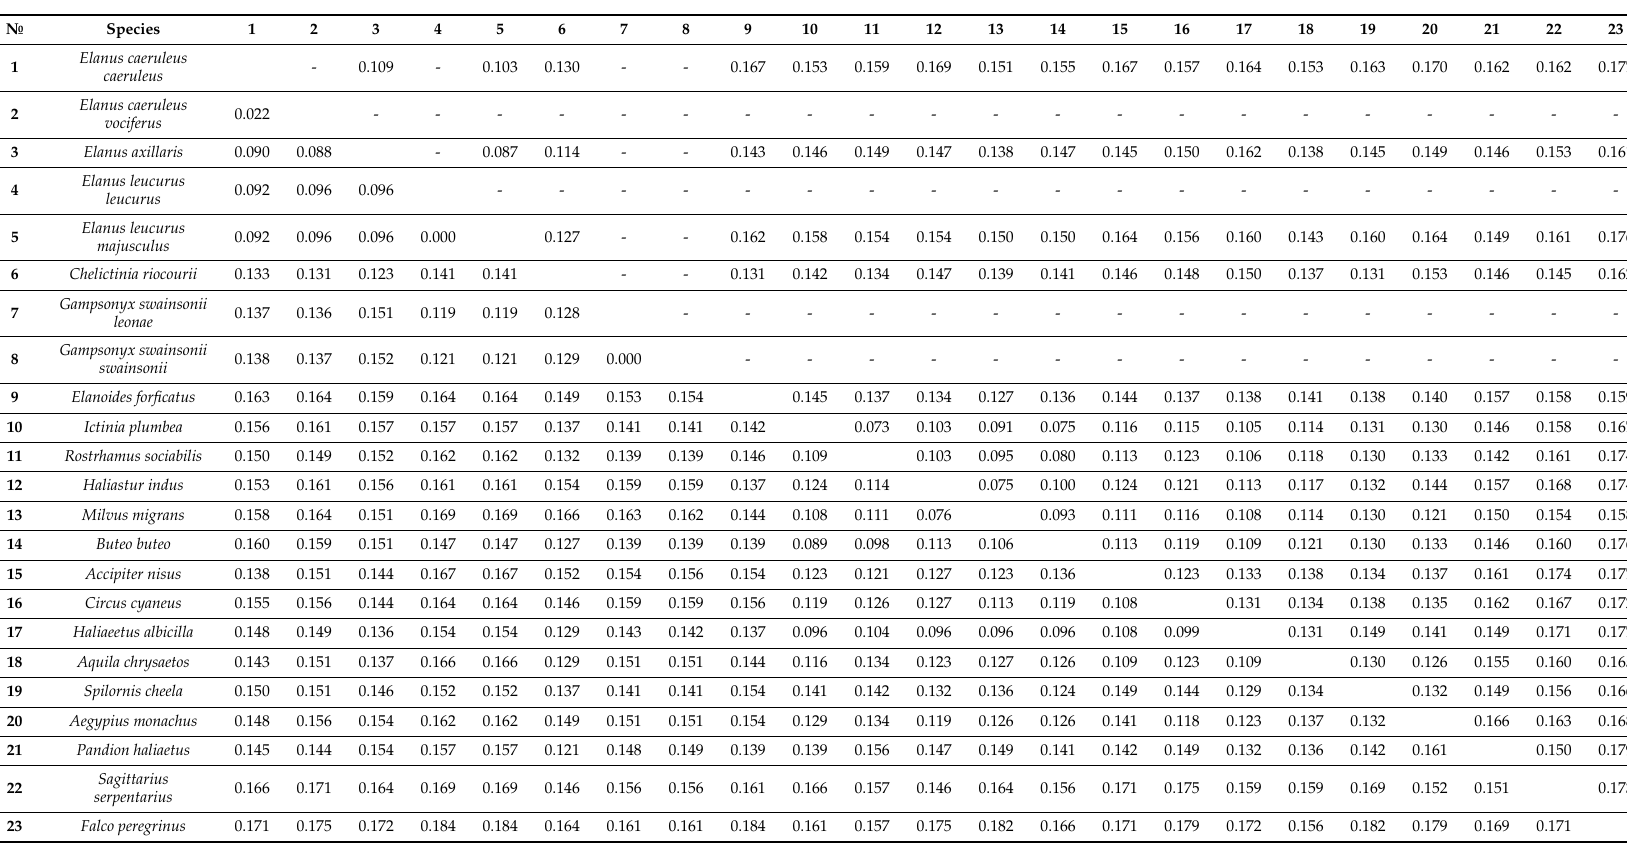
Table 3. Pairwise p-distance values for taxa of Elaninae, Accipitridae, and other diurnal raptors used in the phylogenetic analysis, based on Cyt b (below diagonal) and COI (above